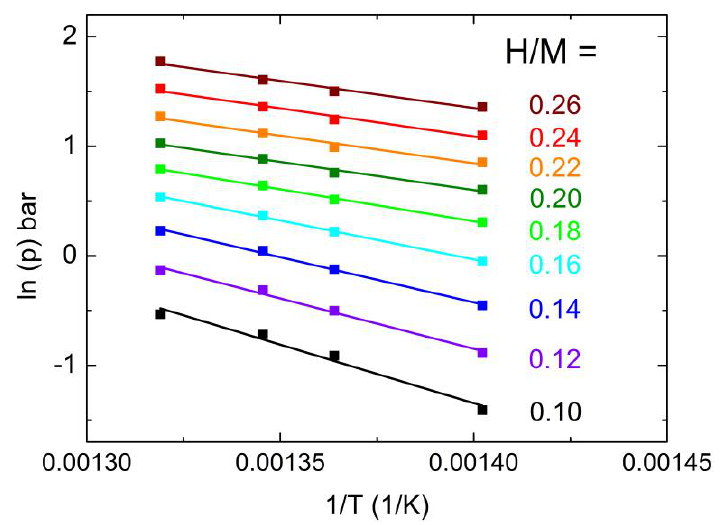
Figure 7. Van’t Hoff plot for the (Ni 0.42 Nb 0.28 Zr 0.30 ) 98 B 2 membrane calculated at different H/M ratios and best fit lines. Table 2.